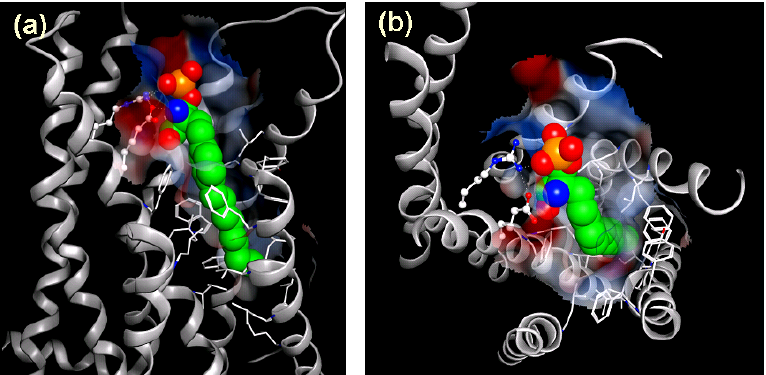
Figure 3. Docking model of S1P with the ( S )-enantiomer of FTY720-P. A model of S1P 1 was constructed by the homology model protocol in Discovery Studio 1.7 (Accelrys Software Inc.). ( S )-FTY720-P is shown in a sphere model, with carbon in green, oxygen in red, nitrogen in blue, and phosphorus in orange. ( a ) side view, ( b ) view from upper side.